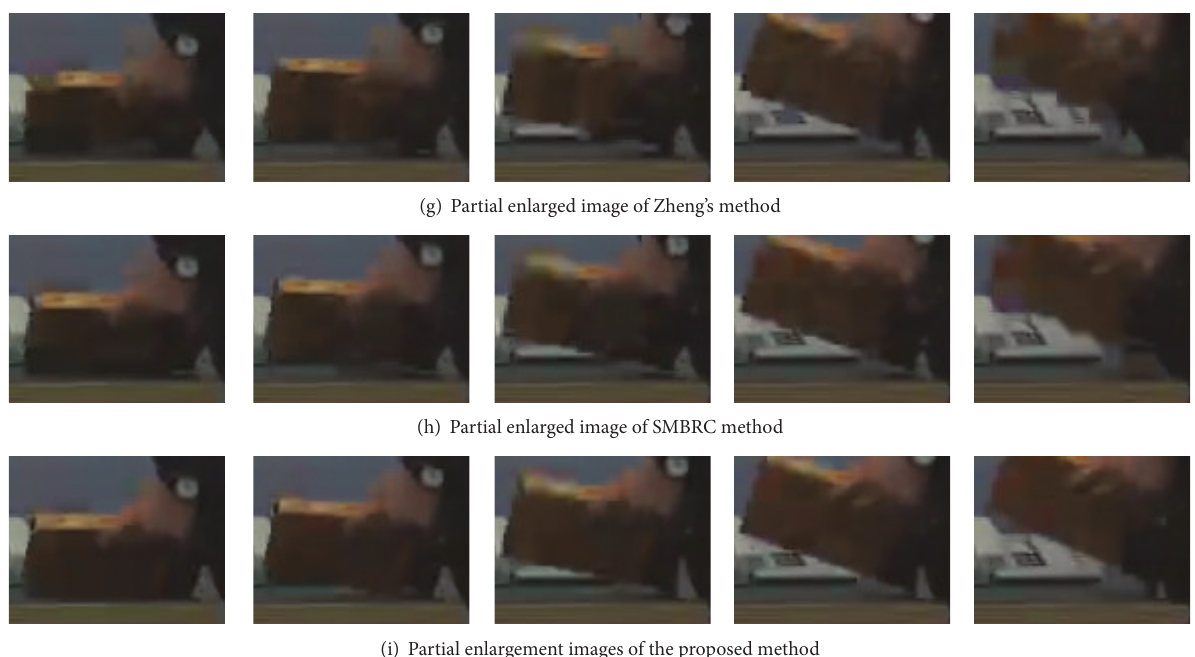
Figure 7: The subjective image comparison for consecutive frames of LeavingLaptop sequence (QP = 37 , the 43th frame to 47th frame in view